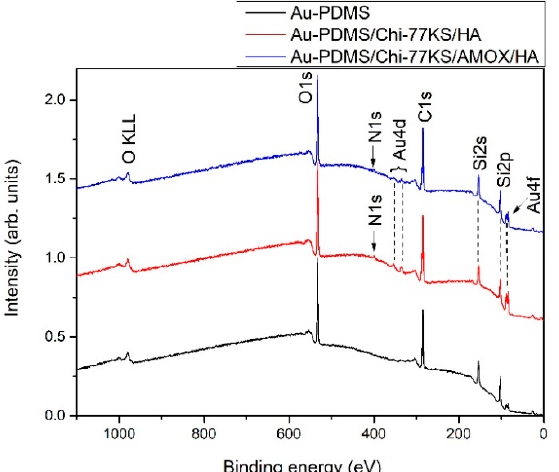
Figure 4. Survey XPS spectra of Au-PDMS, Au-PDMS/Chi-77KS/HA, and Au-PDMS/Chi- 77KS/AMOX/HA.